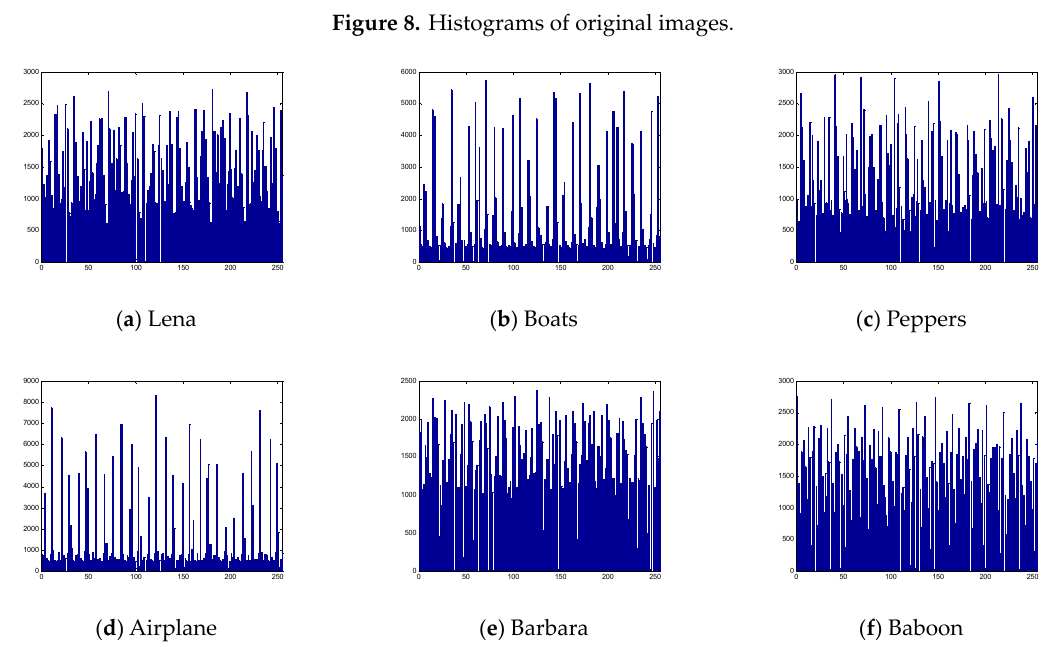
Figure 8. Histograms of original images.